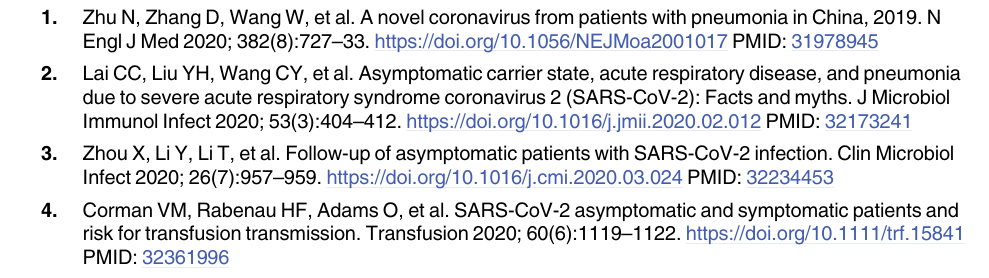
S2 Table. Clinical manifestations of 79 patients with COVID-19. S3 Table. Treatment regimen of 79 patients with COVID-19. S4 Table. Demographics and baseline characteristics of 72 moderate survivors with